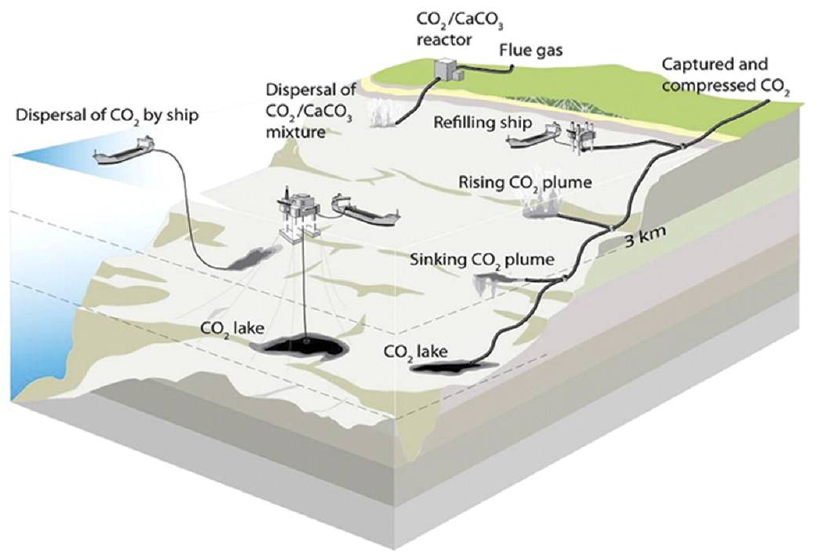
Figure 19. Strategies for ocean carbon sequestration.